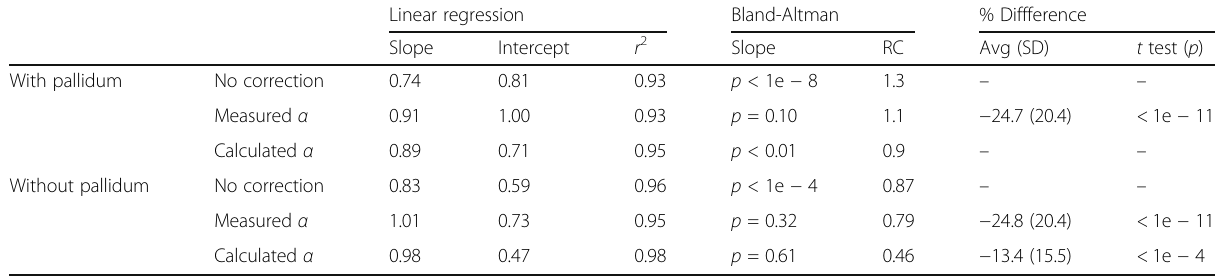
Table 2 Results from applying the correction described in Eq. (11) to DVR values obtained from Logan ref. and [ 18 F]MNI-659. When the slope of the Bland-Altman plot ≠ 0, no average difference can be calculated due to proportionality bias Linear